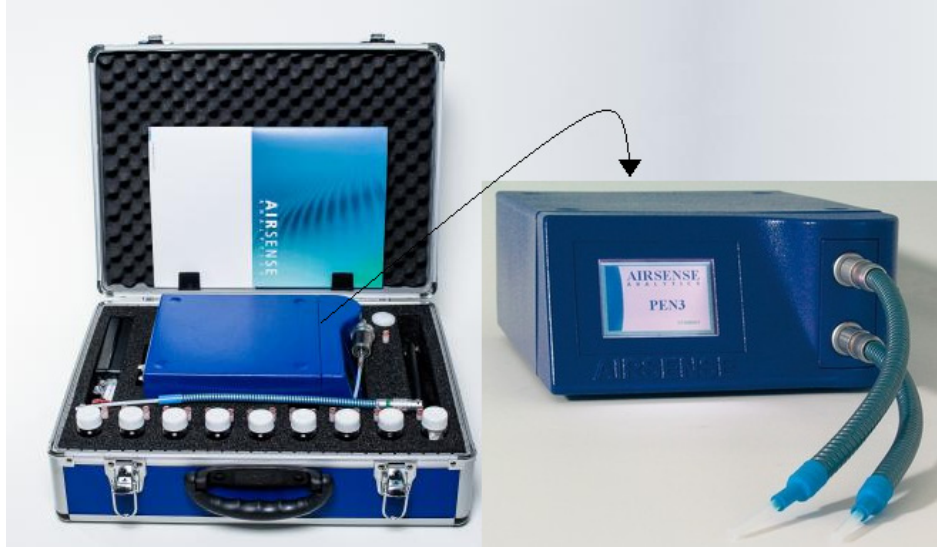
Figure 2. Portable electric nose version 3.5 (PEN